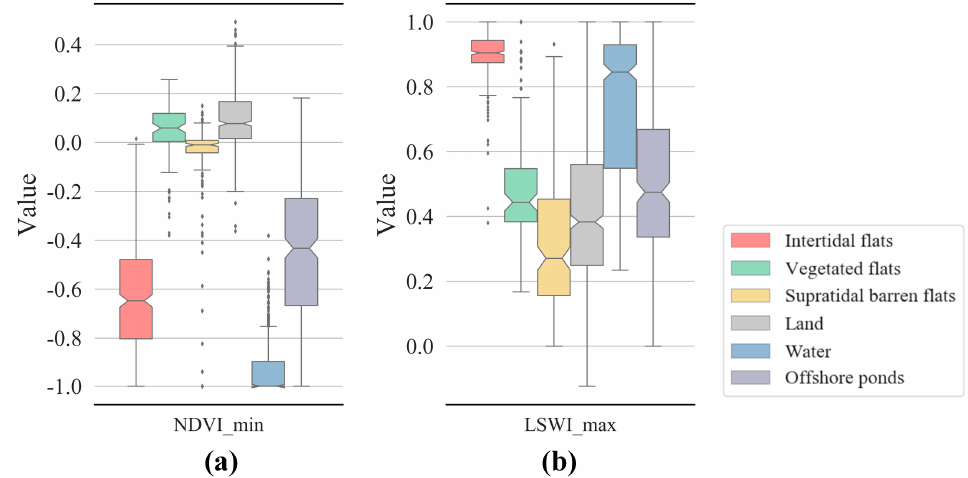
Figure 6. Boxplot of six land use classification knowledge captured to train random forest machine learning algorithm in (a) NDVI minimum and (b) LSWI maximum for POIs. learning algorithm in ( a ) NDVI minimum and ( b ) LSWI maximum for